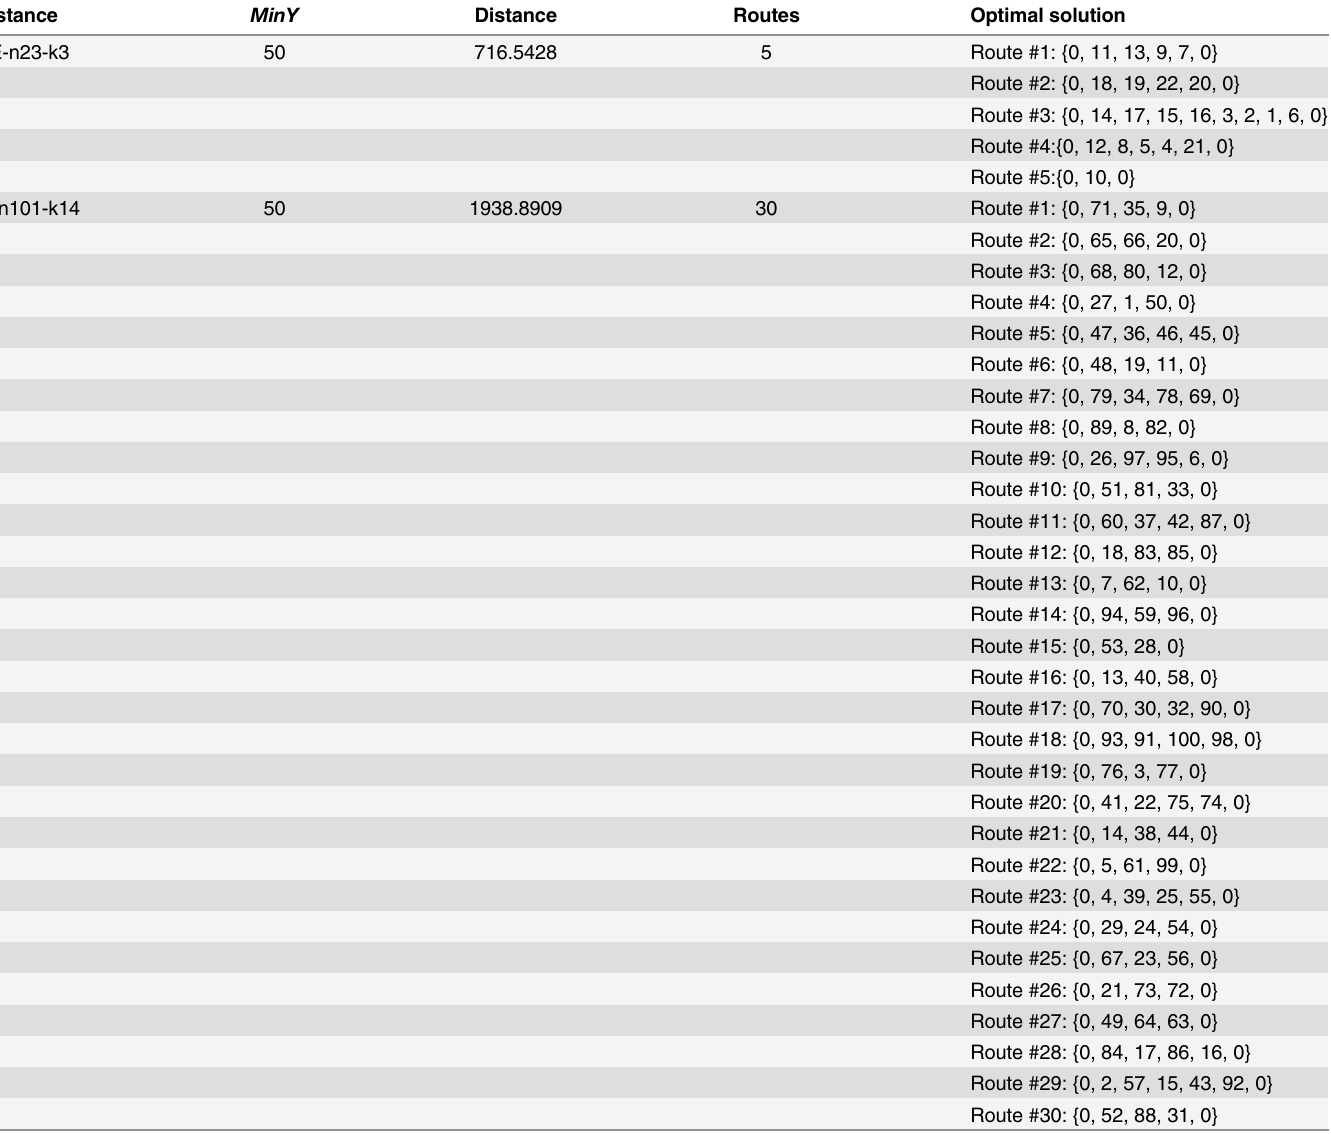
Table 8. Detailed optimization results of MOEA/D-N-UAV on instance E-n23-k3 and E-n101-k14. Instance MinY Distance